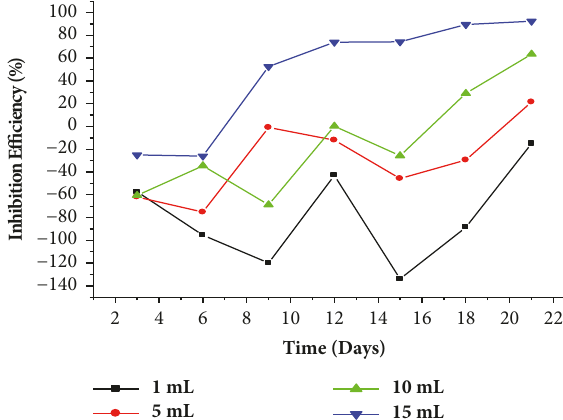
Figure 2: Variation of weight loss against time for the cathodic protection and oil extract for steel with zinc in different volumes of oil extracts in 0.1M sulphuric acid.